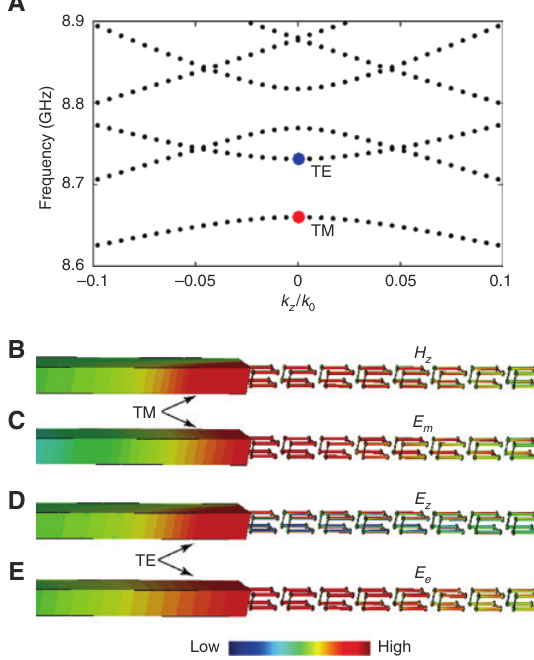
Figure 3: Demonstration of coexistence of TE and TM surface modes by CST Microwave